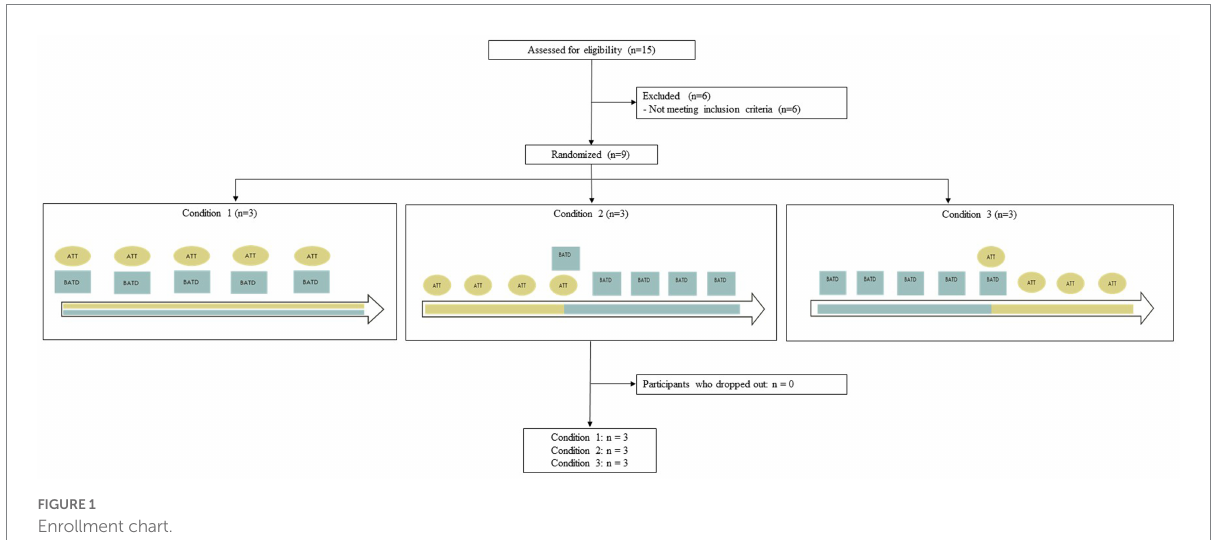
FIGURE 1 Enrollment chart.